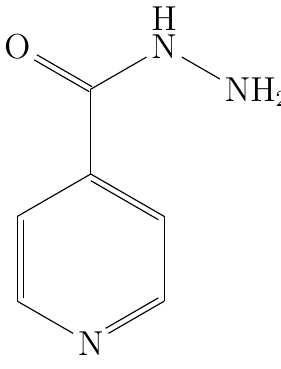
Figure 1. Molecular structure of